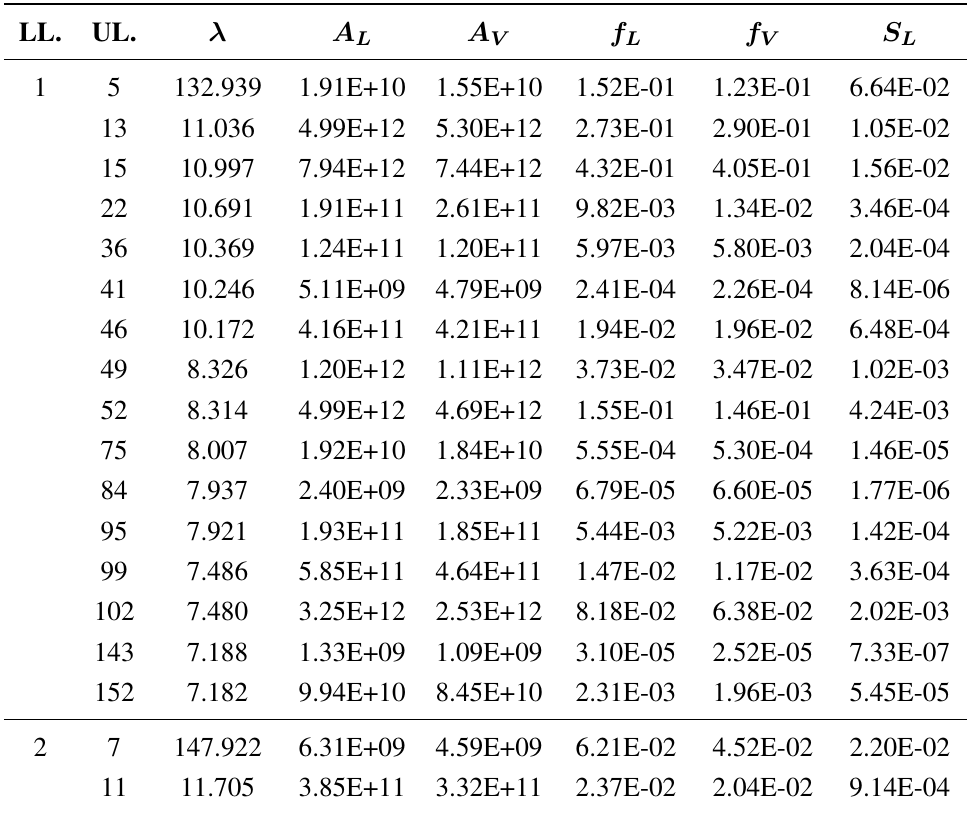
Table 6. Oscillator strengths f , wavelengths (in Å), transition probabilities A (in s − 1 ) and line strengths S (in a.u.) for the transitions in Be-like iron. UL. = upper level; LL. = lower level, V and L indicate velocity and length